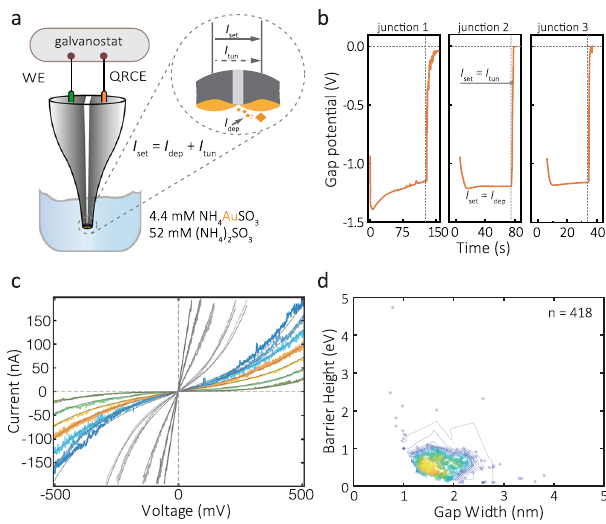
Fig. 2 Electrochemical fabrication and characterisation of the QMT probes. a Gold is deposited via electrochemical deposition at the tip of two coplanar carbon electrodes. The two carbon electrodes were used as working electrode (WE) and quasi-reference counter electrode (QRCE), respectively. A constant preset current, I set , of 20 pA – 10 nA was typically used. Inset: Representation of the working electrodeposition principle. At a chosen I set , gold atoms are deposited onto the WE surface until a tunnelling junction is formed. b Typical chronopotentiometric response during the electrodeposition process with different preset currents of I set : 20 pA, 100 pA and 1 nA. The electroplating solution contains 4.4 mM NH 4 AuSO 3 and 52 mM (NH 4 ) 2 SO 3 . c Tunnelling current − bias ( I – V ) measurement of the resulted QMT probes in air at room temperature (297 K). The solid curves in c are the data fi ts using the Simmons model. It all cases the goodness of fi t based on χ 2 was on the order of 10 − 8 . d Density scatter plot of the gap width of 418 probes as a function of barrier height (density: high in yellow, low in navy blue). Both the gap width and barrier height were obtained from the Simmons model for QMT probes measured in